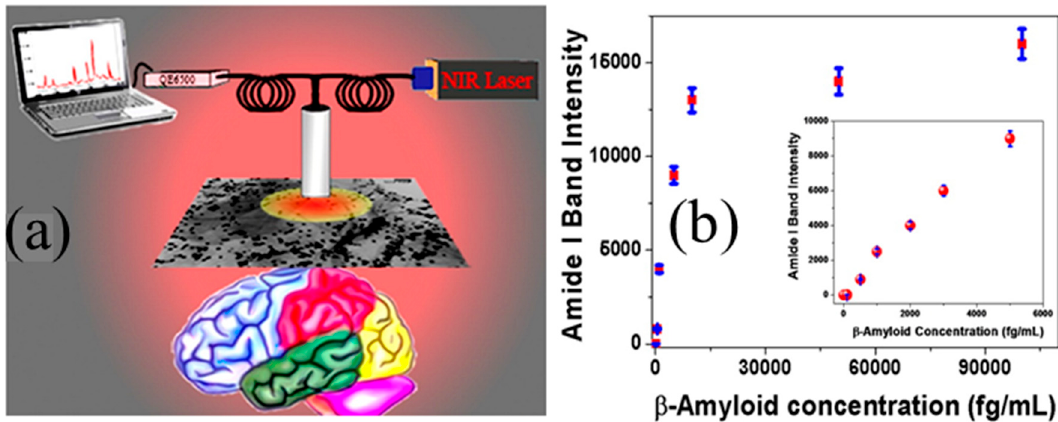
Figure 4. ( a ) Schematic of plasmonic-magnetic hybrid graphene oxide-enabled surface-enhanced Raman spectroscopy (SERS) platform for detecting AD biomarkers and ( b ) measured SERS amide I band intensity from A β conjugated nanoplatform changes with concentration between 0 and 6 pg/mL. The limit-of-detection (LOD) can be as low as 500 fg/mL. Reproduced from reference [80] with permission from American Chemical Society.